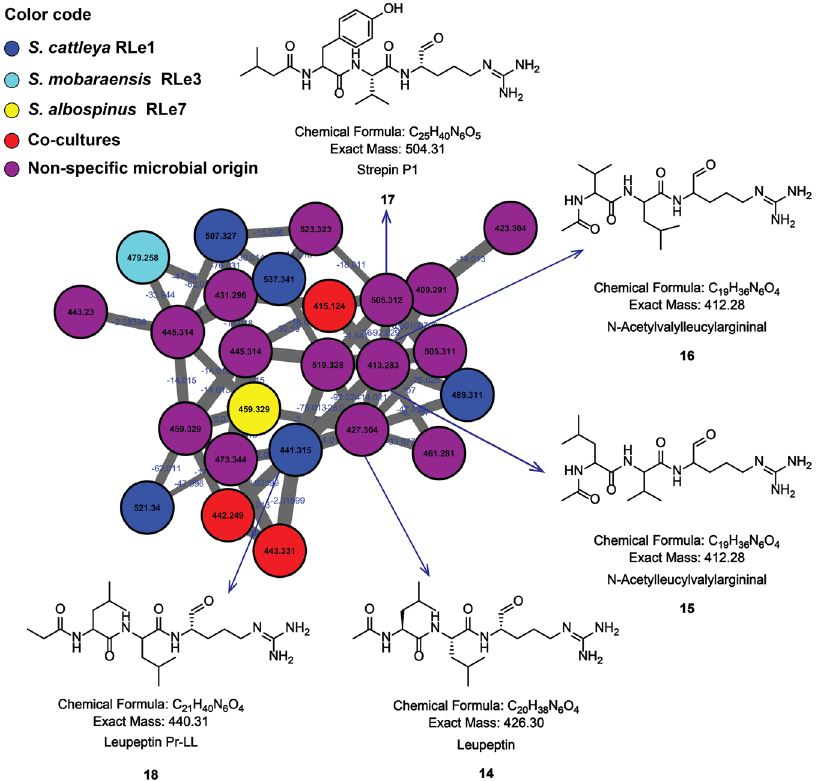
Figure 4. Leupeptin-cluster from the molecular network of interactions among endophytic microorganisms from L . ericoides . Nodes from co-cultures are red, nodes from several strains (unspecified microbial origin) are purple, nodes from mono- and co-cultures of S . cattleya RLe1 are in blue, nodes from mono- and co-cultures of S . mobaraensis RLe3 are in aquamarine, nodes from mono- and co-cultures of S . albospinus RLe7 are in yellow.